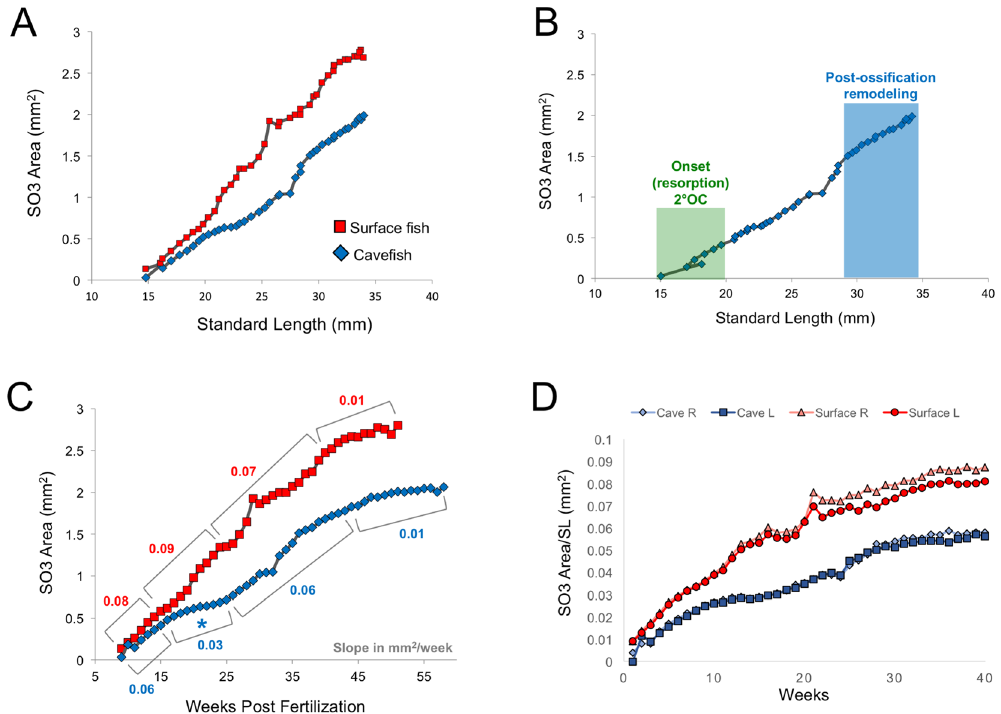
Figure 3. Growth metrics for SO3 ossification in surface and cavefish. There is a linear relationship between SO3 growth (area in mm 2 ) and body size (SL in mm) for both surface (red; n = 16) and cavefish (blue; n = 30; A ). The window for the spontaneous onset and resorption of 2°OCs in cavefish is small, ranging from an average of 10–14.5 wpf or 15–20 mm SL ( B ; green). Ectopic OCs that persisted past this window remained separated fragments when fish reached adulthood. Post-ossification bone remodeling occurred later when the fish reached between 30–35 mm SL or 30–40 wpf ( B ; blue). Surface fish have larger SO3 bones that grow at a faster rate than cavefish across weeks post fertilisation (wpf) ( C ). Cavefish undergo a plateau in SO3 ossification from 15–25 wpf, growing at 0.03 mm 2 /week compared to 0.09 mm 2 /week ( C ). Both morphs reached adult SO3 bone areas at approximately 45 wpf, with diminutive growth thereafter (0.01 mm 2 /week). Average SO3 areas normalised to SL for each morph were measured for both the right and left sides of the face across the number of weeks they were analysed ( D ). There was no appreciable difference between cavefish right (light blue) and left (dark blue) SO3 area over 40 weeks of imaging. There was a slight difference between surface fish right (light red) and left (dark red) areas after 20 weeks of imaging.